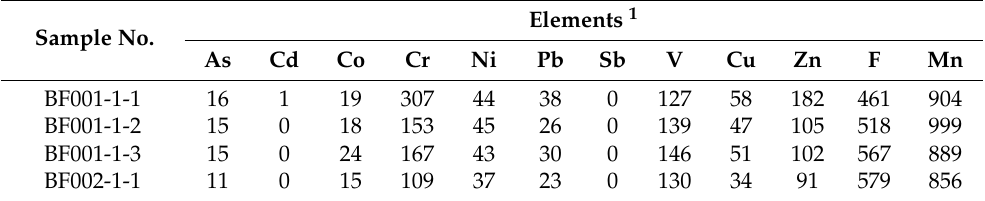
Table A1. Environmental background values of soil heavy metal elements in Wuhu City. Sample